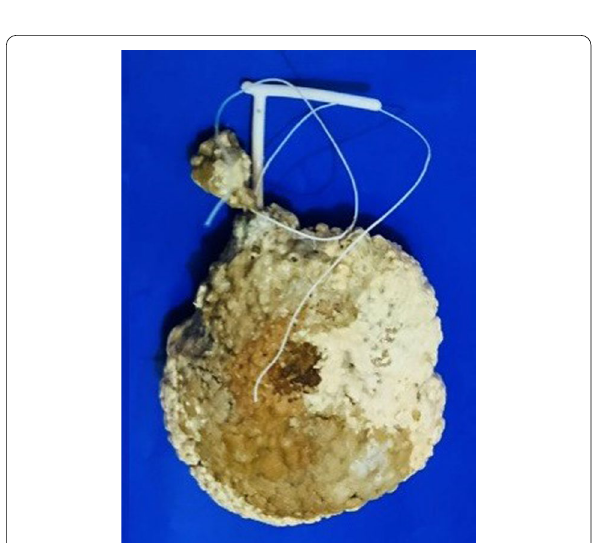
Fig. 2 Image showing a giant vesical calculus along with IUCD removed through open